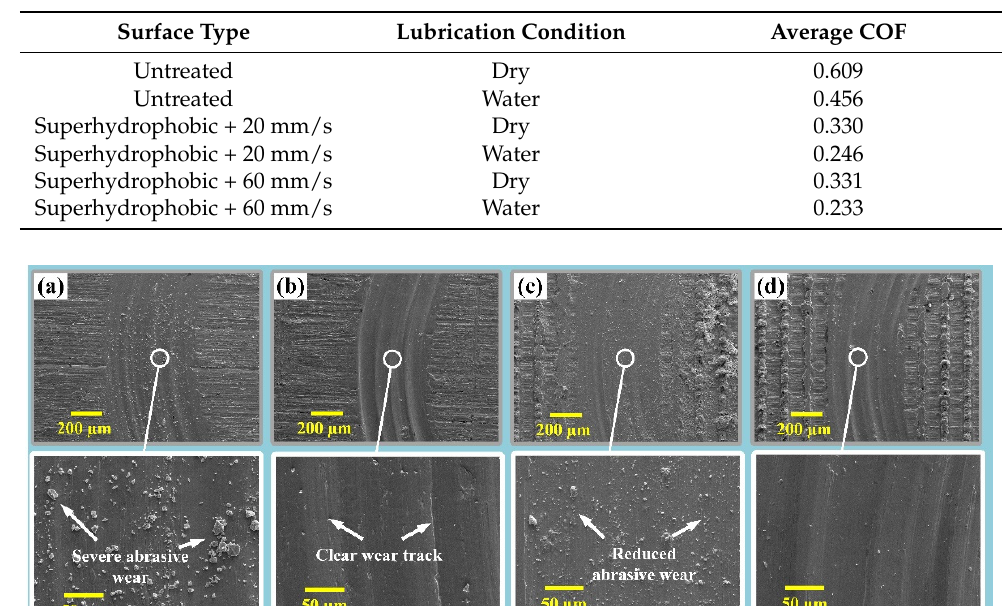
Table 3. Average COF for different types of BMG surfaces under dry sliding and water lubrica- tion conditions.